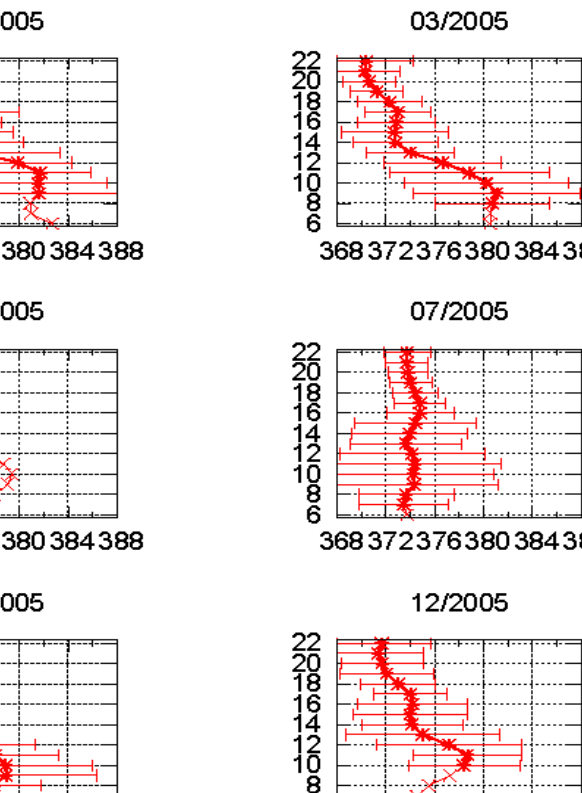
profiles for each altitude. ACE thin red line 2